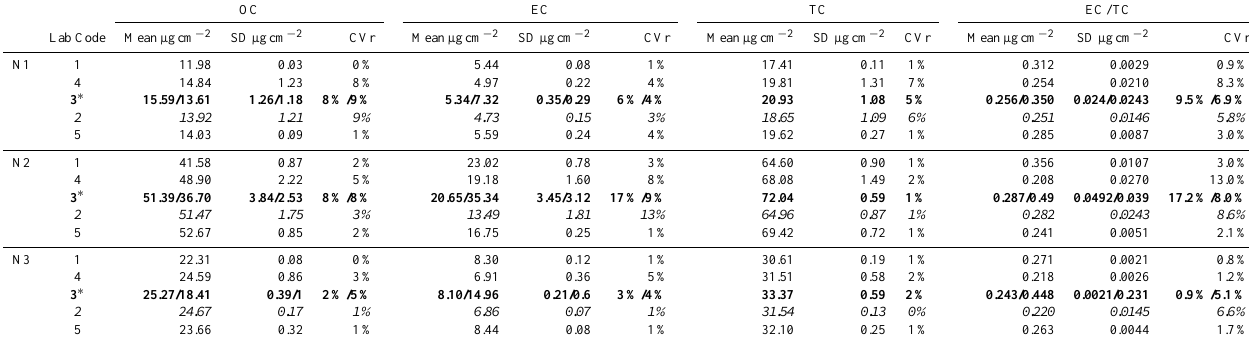
Table 3. Mean, standard deviation (SD), repeatability relative standard deviation calculated for OC, EC, TC and EC/TC ratio for each laboratory and each filter (N1, N2 and N3).